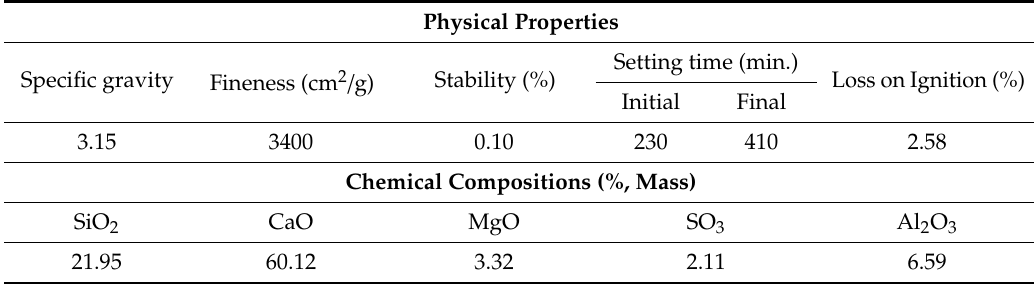
Table 1. Material properties of ordinary Portland cement